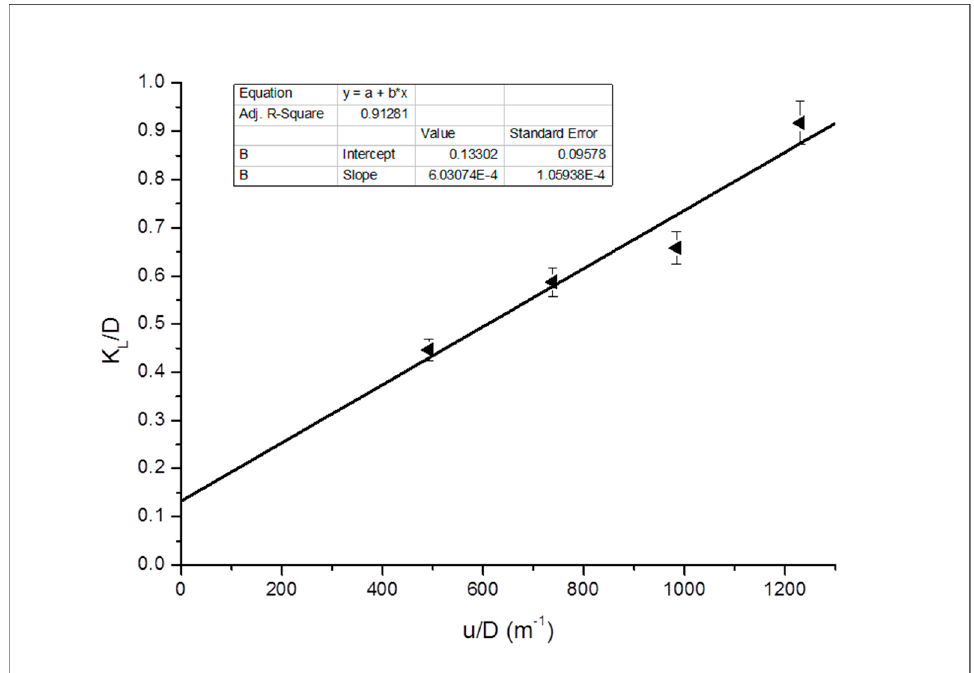
Figure 12. Dispersivity evaluation for Buff Berea in the horizontal orientation.